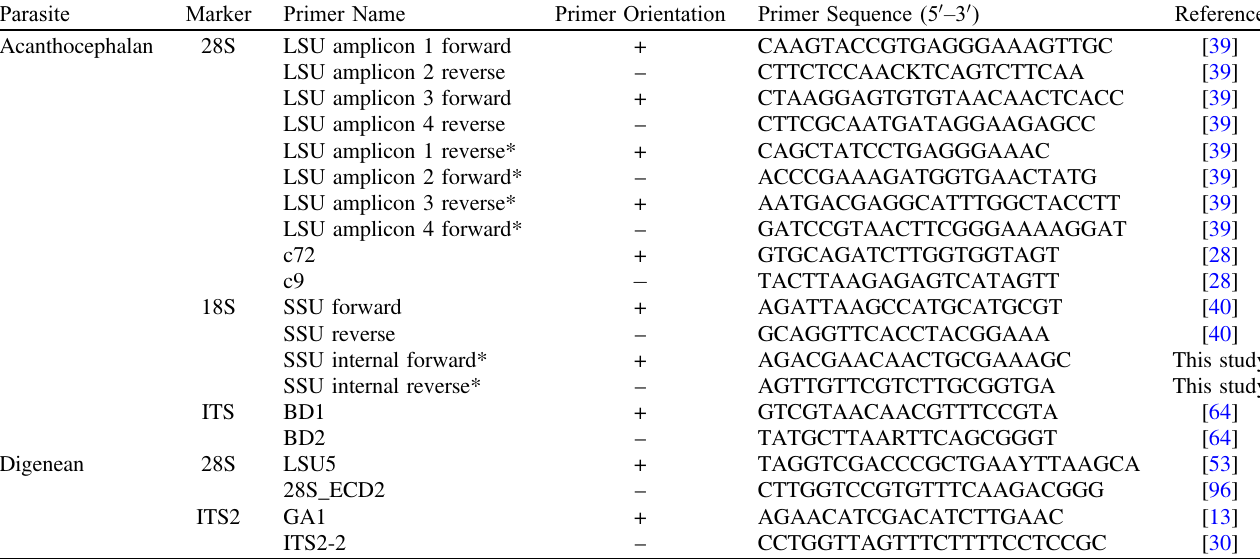
Table 2. Primers used for PCR ampli fi cation and sequencing; primers used only for sequencing are indicated by an asterisk. 28S = a portion of the large subunit ribosomal RNA (rRNA) gene, 18S = a portion of the small subunit rRNA gene, ITS = the internal transcribed spacer region of the rRNA gene. For primer orientation, + = sense, (cid:3) =